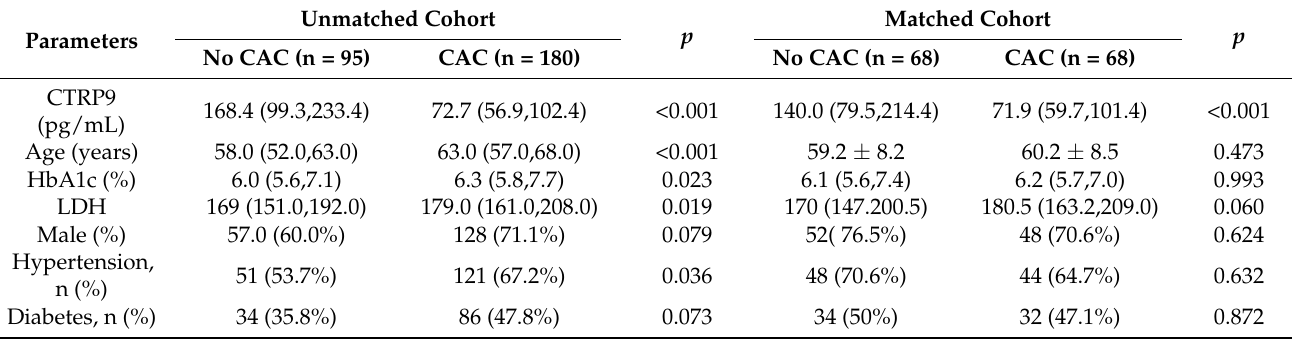
Figure 3. Predictive value of plasma CTRP9 level on CAC. Receiver operating characteristic (ROC) curves for predicting CAC. The AUC was 0.796 (95% CI: 0.744–0.842, p < 0.001), the cut-off value was 109.17 pg/mL (sensitivity 80.6%, specificity 71.6%). CI, confidence interval; AUC, area under the curve. CTRP9 and C1q/TNF-related protein 9 expression. Table 2. Comparison of baseline characteristics between patients with CAC and patients with- out